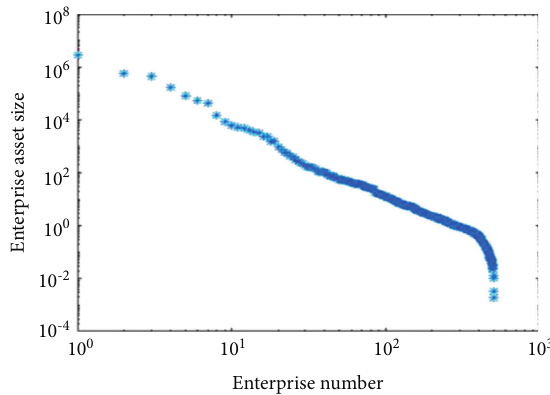
Figure 4: Asset size distribution of firms (double logarithmic